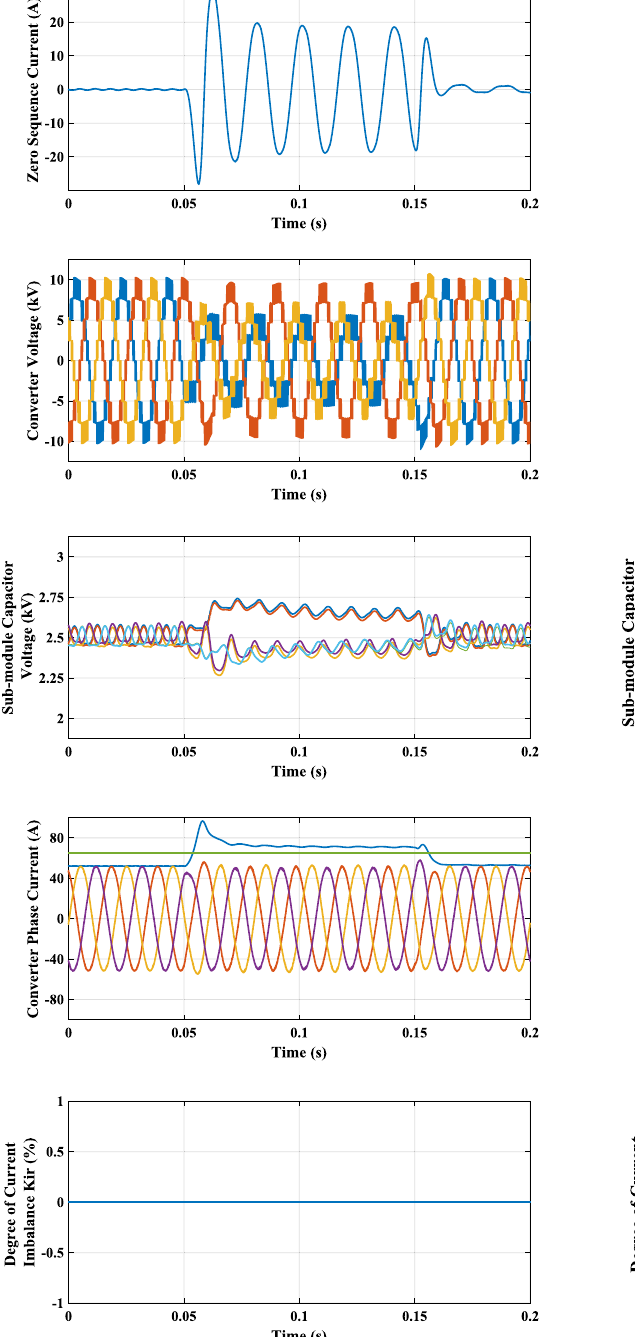
Fig. 8 Simulation result using zero sequence current injection technique. a Zero sequence current. b Converter output voltage. c Inter-cluster dc sub-module capacitor voltages. d Converter phase currents. e Degree of current imbalance